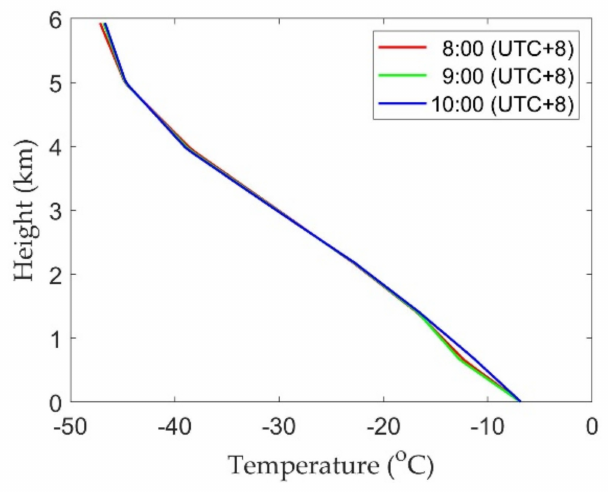
Figure 9. Hourly temperature profile from 0800 to 1000 on 3 March